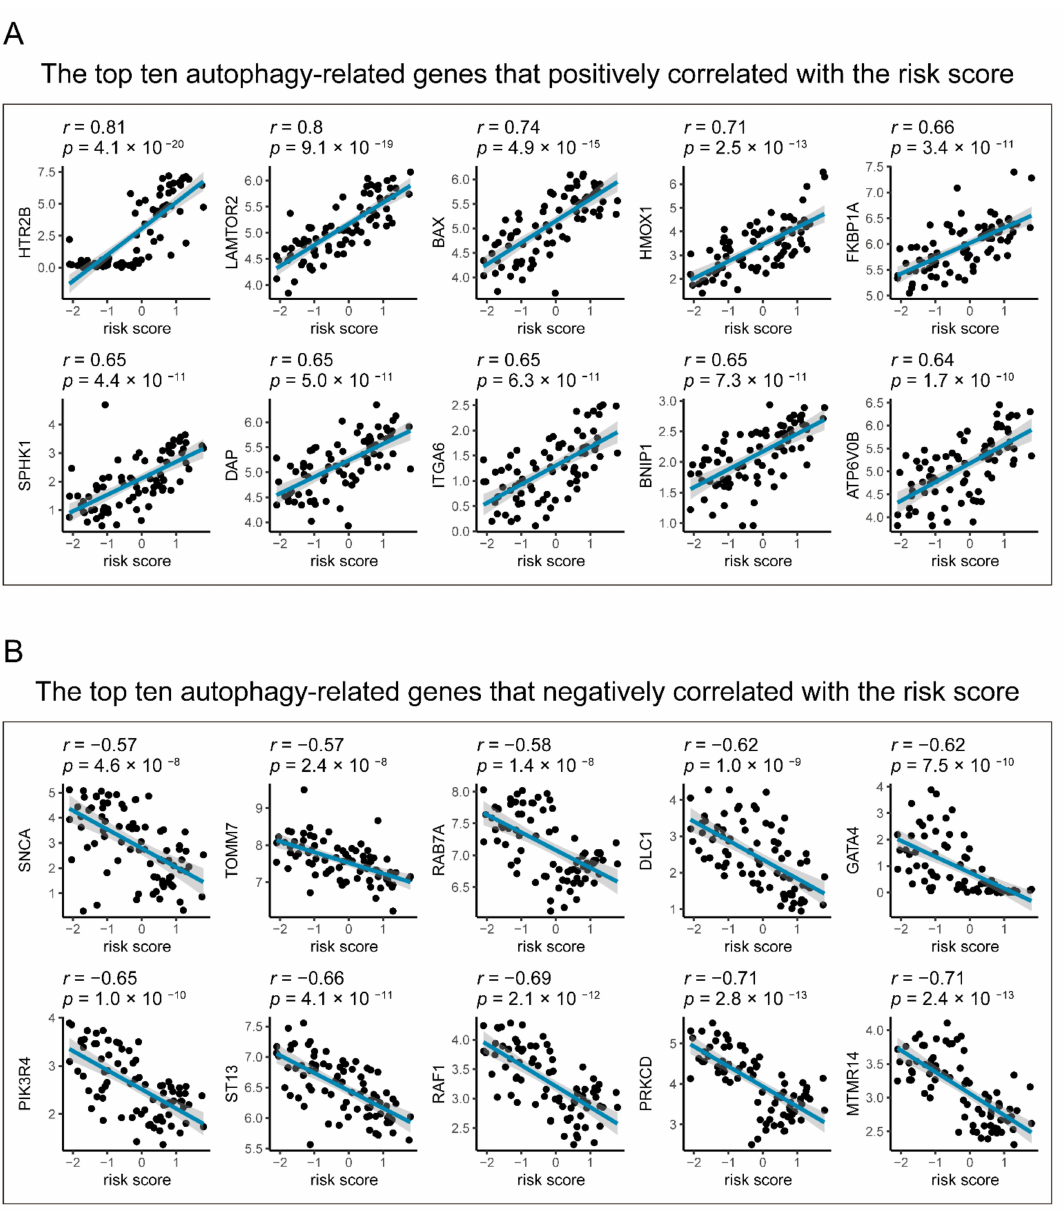
Figure 7. Correlations between the gene signature and the autophagy-related genes in UM. The blue line in each graph ( A , B ) fits a linear model that indicates the proportional trend of the expression level of each gene and the risk score. The grey shading around the blue line indicates a 95% confidence interval. Pearson coefficients examine the correlation test. Only top ten positive and negative correlations are plotted. UM: uveal